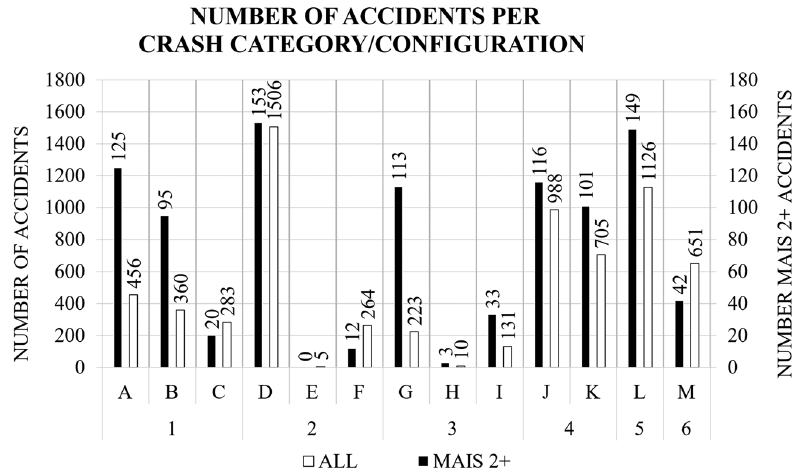
Figure 3: Frequency of all V2V crashes and crashes with MAIS 2 + injuries according to the analysis of the CISS database [ 53 ] .